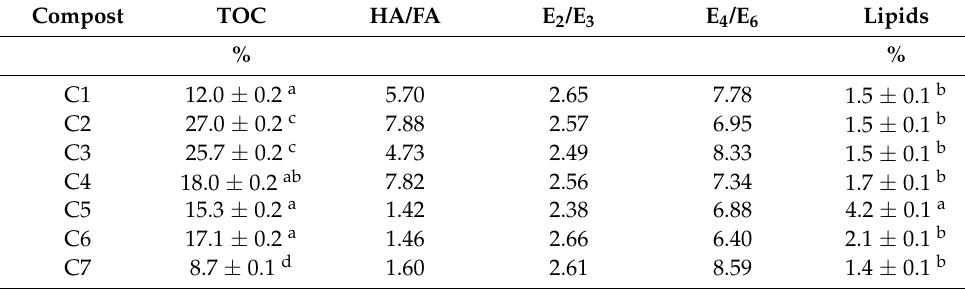
Table 3. Characterization of HSs in composts. TOC = total organic carbon in humic substances. TOC and lipids are presented as % of compost dry matter. Mean ± standard deviation (SD) of triplicate measurements compared using ANOVA with post-hoc Tukey’s HSD test. Connecting letters represent significantly different